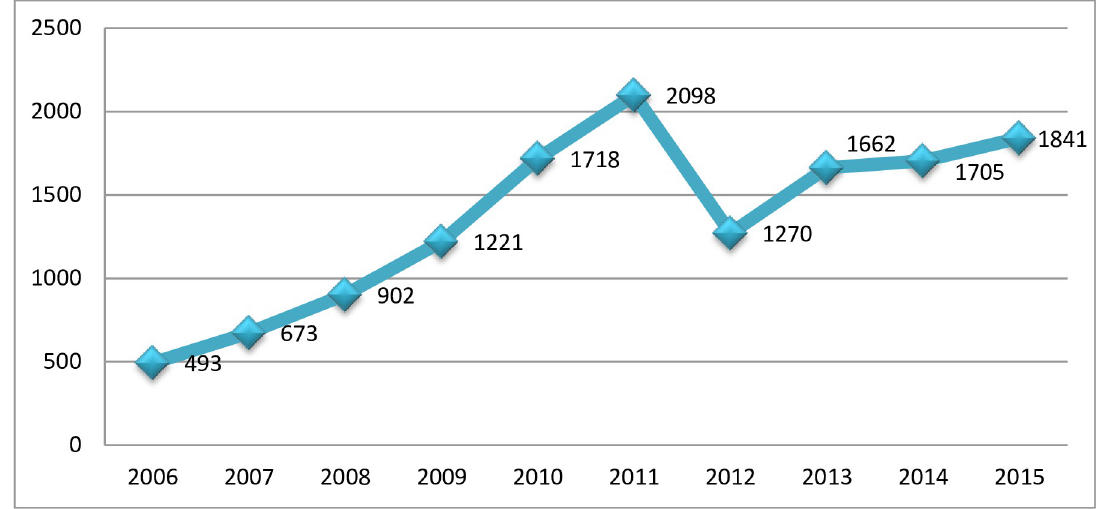
Fig 1. Total number of calls received by the National Poison Centre from 2006–2015 involving individuals 18 years and under.